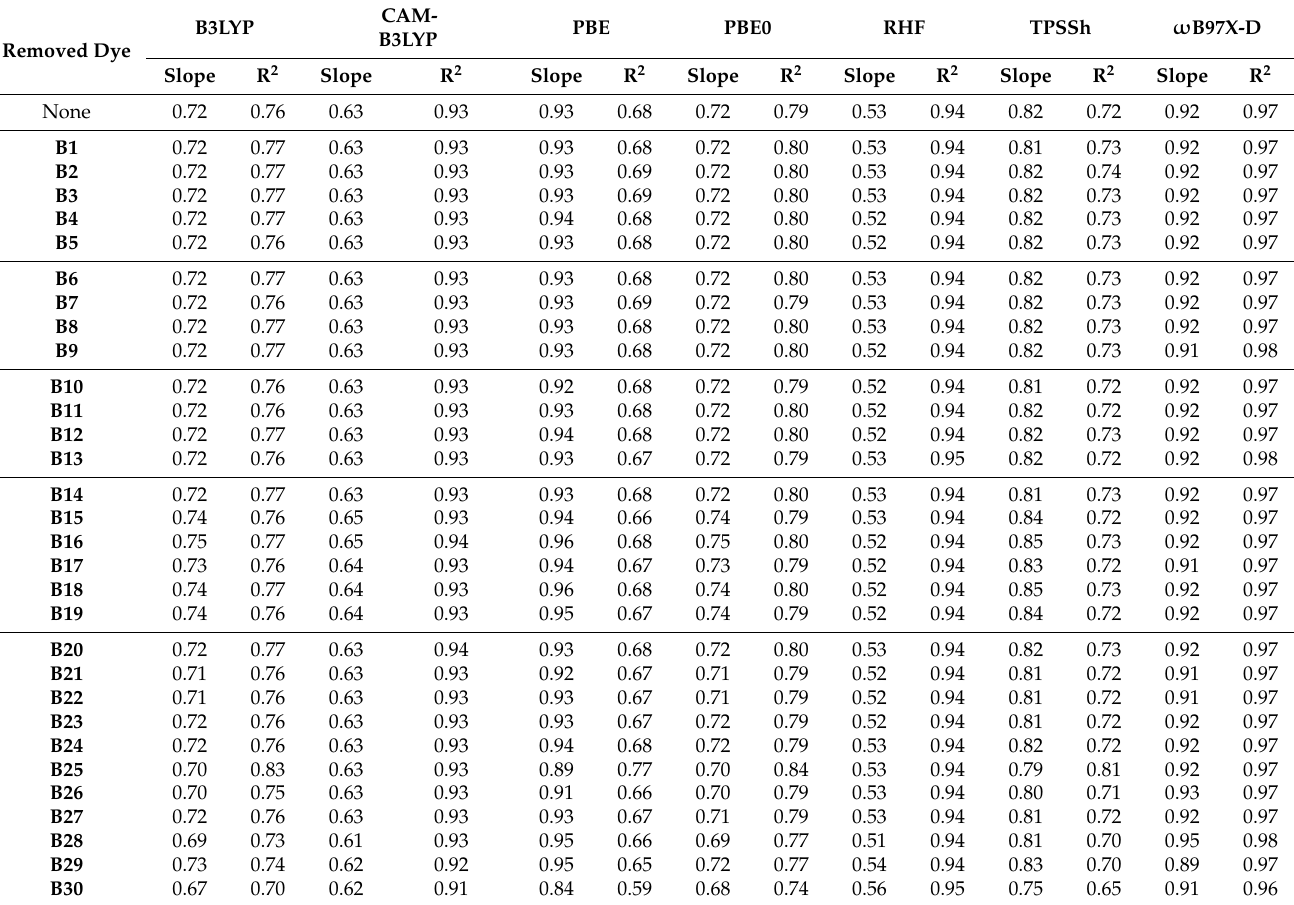
Table A2. Variation of the parameters R 2 and slope when adding or removing one dye at the time from the training data set for each computational